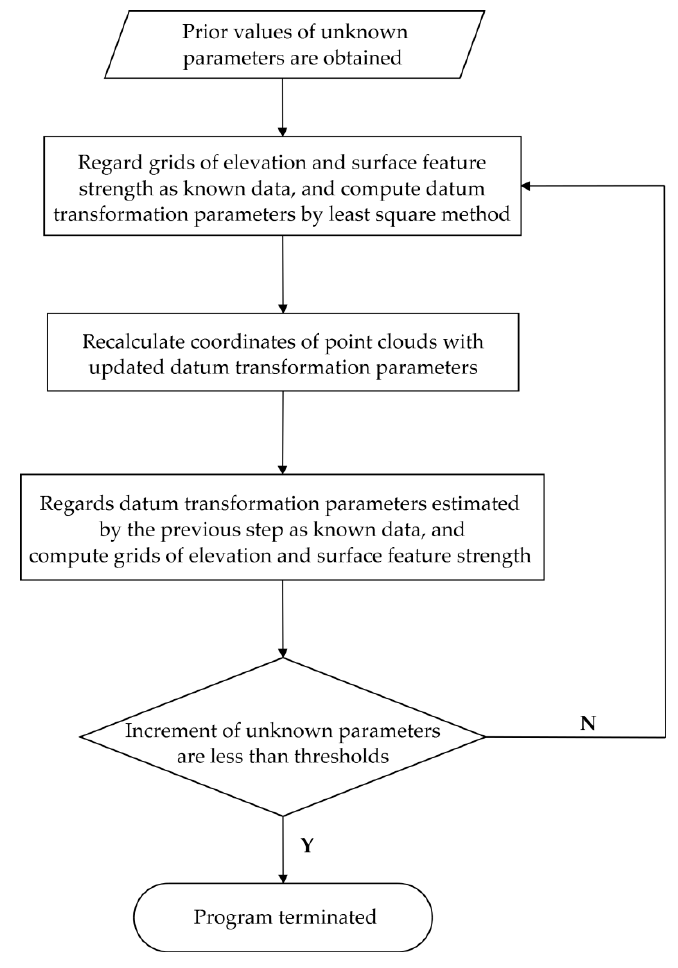
Figure 3. Flowchart of strip adjustment by using the partial least squares (PLS) method.